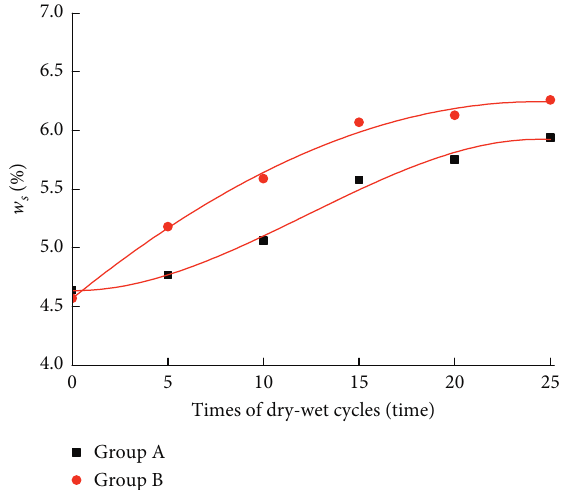
Figure 5: Average saturated water absorption rate of the feldspar sandstones after a dry-wet